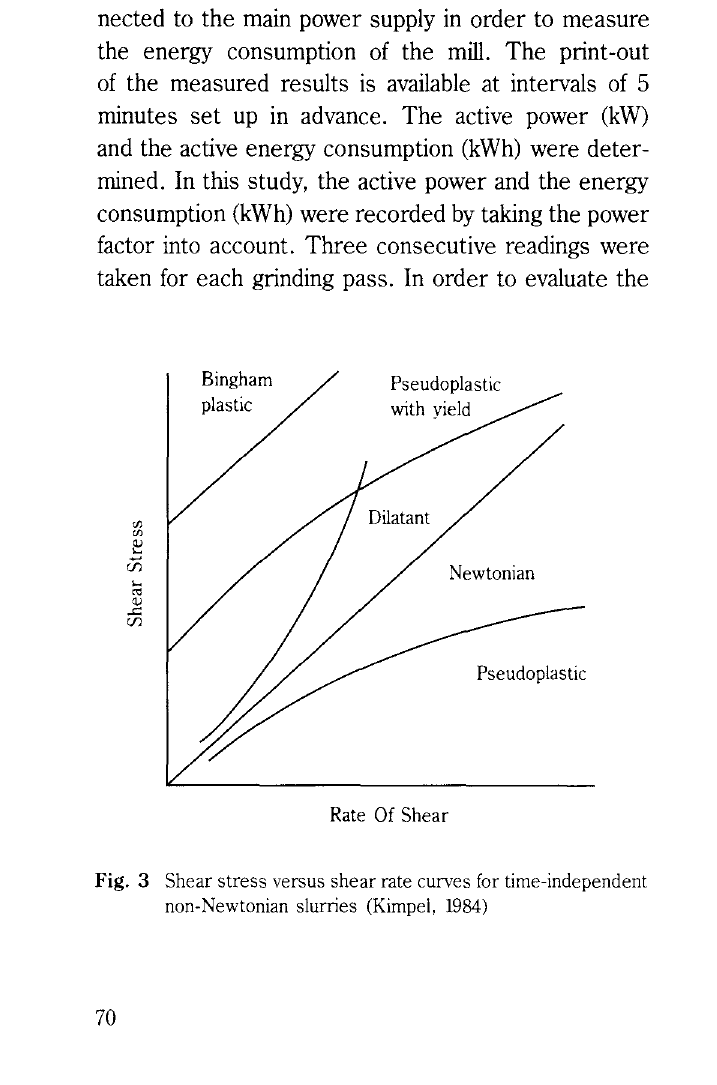
Fig. 3 Shear stress versus shear rate curves for time-independent non-Newtonian slurries (Kimpel,